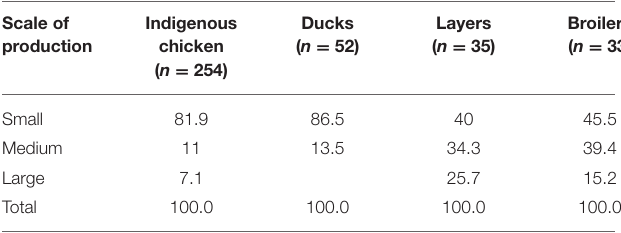
TABLE 2 | Scale of poultry production in Thika and Kisumu, 2016. Scale of